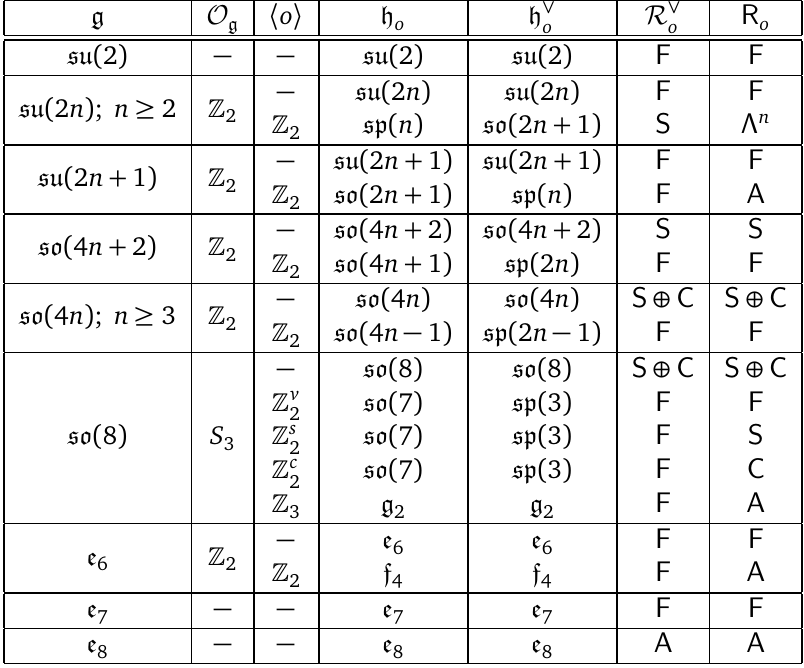
Table 1: Various data used throughout the paper. g is a Lie algebra of A , D , E type that specifies the ( 2,0 ) theory. O denotes the outer-automorphism group of g . A dash g denotes a trivial O . S denotes the permutation group of 3 objects. 〈 o 〉 denotes the g 3 subgroup of O generated by the outer-automorphism o . A dash denotes a trivial g choice of o . (cid:90) v , (cid:90) s , (cid:90) c are the subgroups of O generated by outer-automorphisms g 2 2 2 that leave invariant the vector, spinor and co-spinor irreps of so ( 8 ) respectively. h is the subalgebra of g left invariant by o . h ∨ is Langlands dual of h o resentation of h ∨ and R is a representation of g that descends to R ∨ o o